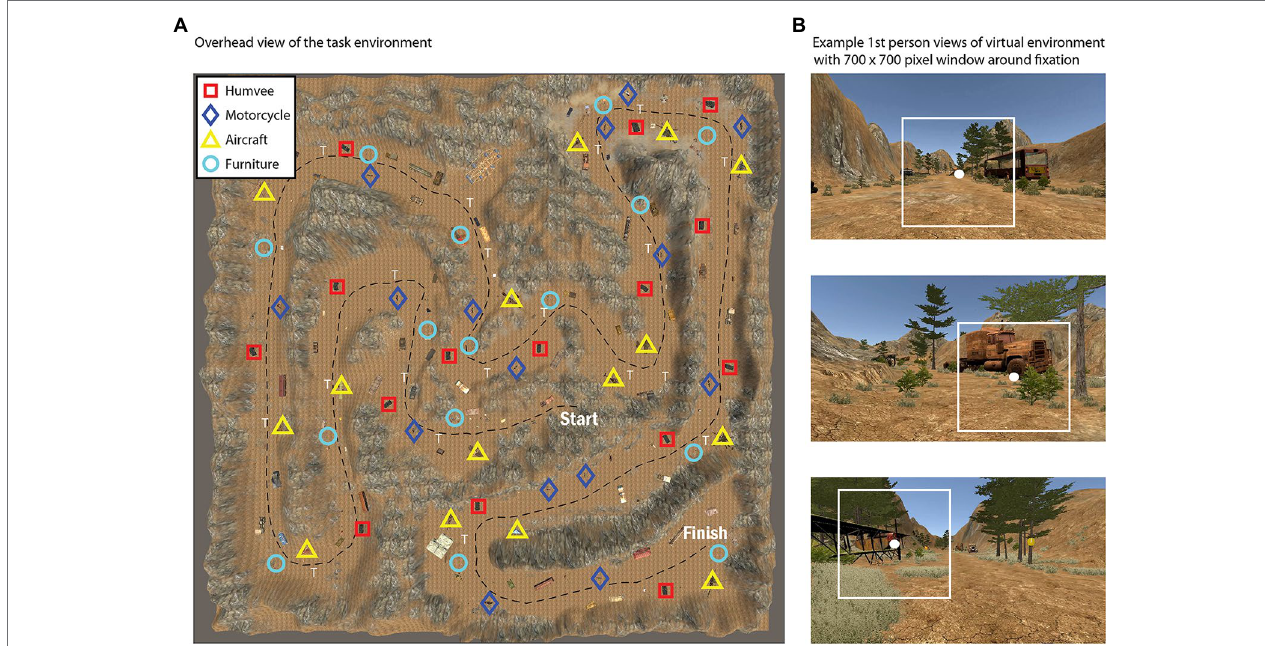
FIGURE 1 | Overhead view of the task environment during the active visual search and navigation task (A) , with symbols representing the location of various target types (Humvee, Motorcycle, Aircraft, or Furniture). For further illustration, (B) shows selected snapshots of the first person view during the task with a 700 × 700 pixel box surrounding